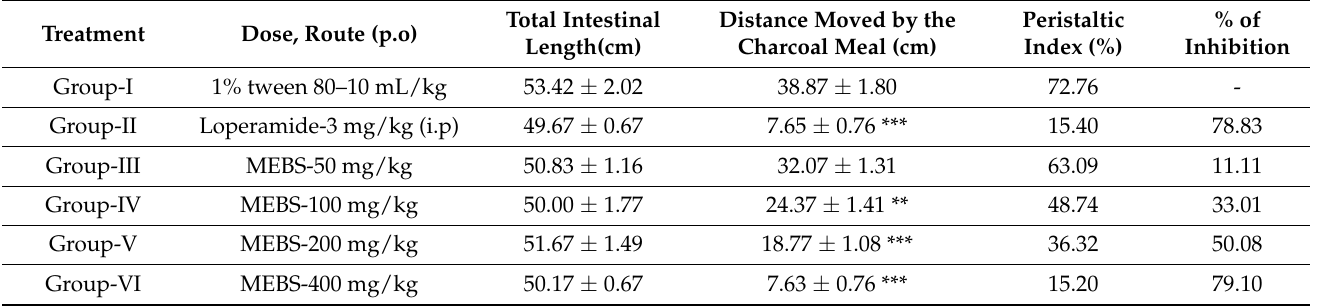
Table 4. Impact of the test samples on intestinal transit in